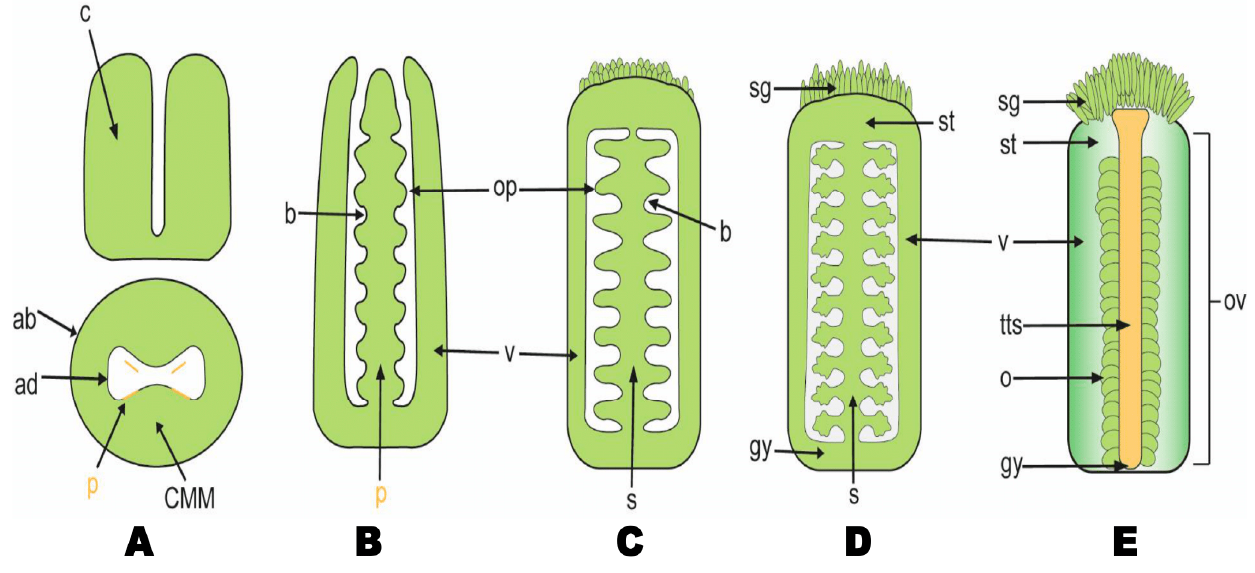
Figure 1. Model diagram elaborating ovule formation in Arabidopsis. The instance specifies ovule formation and developmental stages. ( A ) CMM formation, ( B ) ovule identity, ( C ) ovule initiation, ( D ) integument development, and ( E ) gynoecium development. Abbreviations: ab, abaxial; ad, adaxial; b, boundary; CMM, carpel margin meristem; c, carpel; gy, gynoecium; o, ovule; op, ovule primordium; ov, ovary; p, placenta; s, septum; sg, stigma; st, style; tt, transmitting tract; v, valve. The region of the CMM where the placenta is formed is indicated with orange lines. The ovule initiation and gynoecium developmental process are according to [3,6].